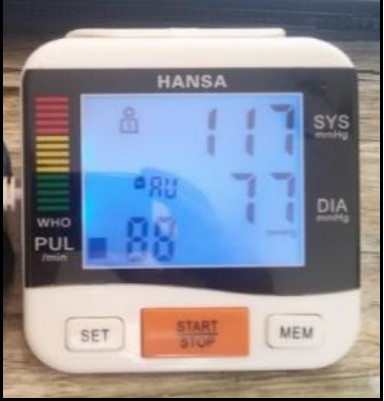
Figure 5. The BM device.